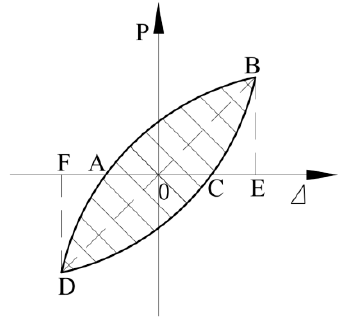
Figure 14. Energy dissipation index calculation.